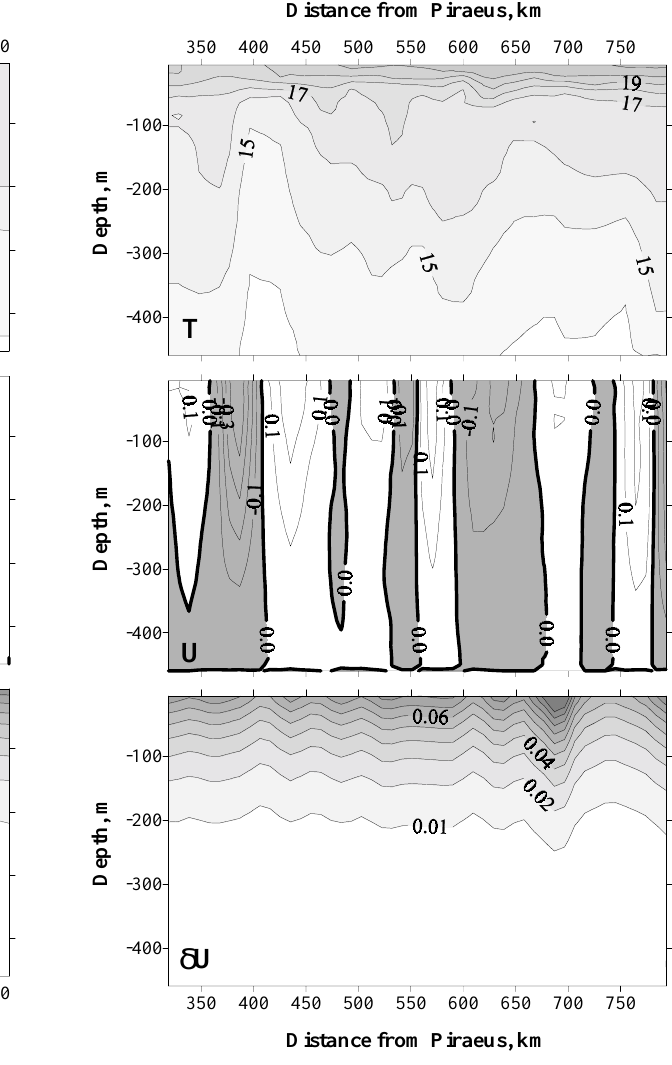
Fig. 7c. As in Fig. 7a, for the 7th crossing on 17 March 2000.